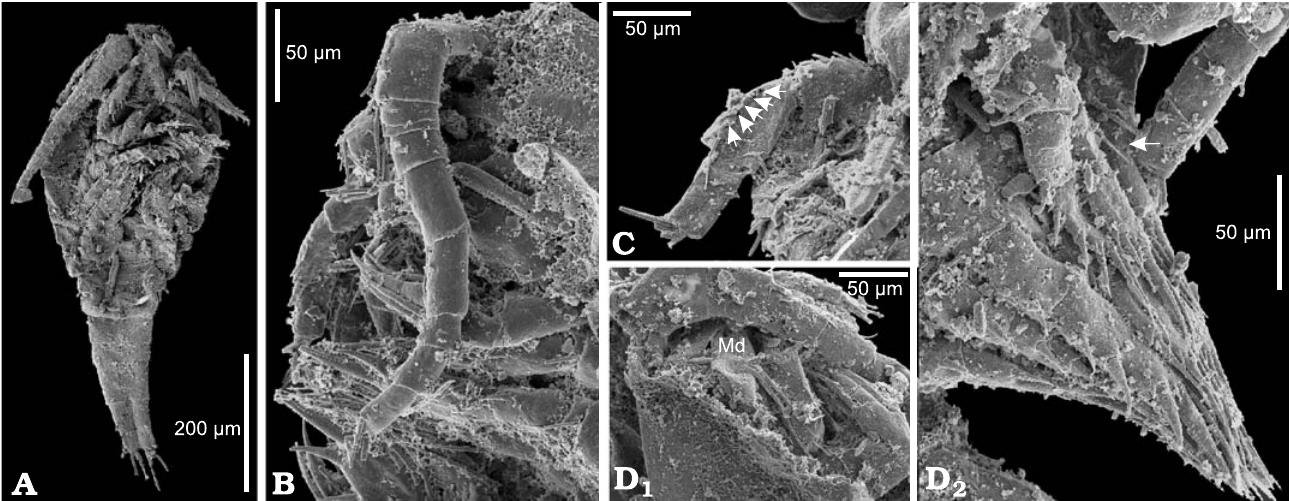
Fig. 7. Copepodid V of cyclopid copepod Apocyclops californicus sp. nov. from Mud Hills, Southern California; Burdigalian–Langhian, Miocene. A . UMNH IP 4825, male, habitus in ventral view. B . UMNH IP 4857, female, 11-segmented antennule. C . UMNH IP 4854, sex cannot be determined, antenna with allobasis in ventral view; arrows show the insertion sites of five setae on the medial margin of the penultimate segment of the antennal endopodite. D . UMNH IP 4832, sex cannot be determined. Antennule (segments 1 − 8), coxopodite of the mandible (Md) with palp bearing two long and one short setae, maxillulary arthrite and maxilla (D 1 ). Swimming legs 1 to 4 in lateral view (D 2 ), arrow points to the medial spine of leg 1 basipodite.